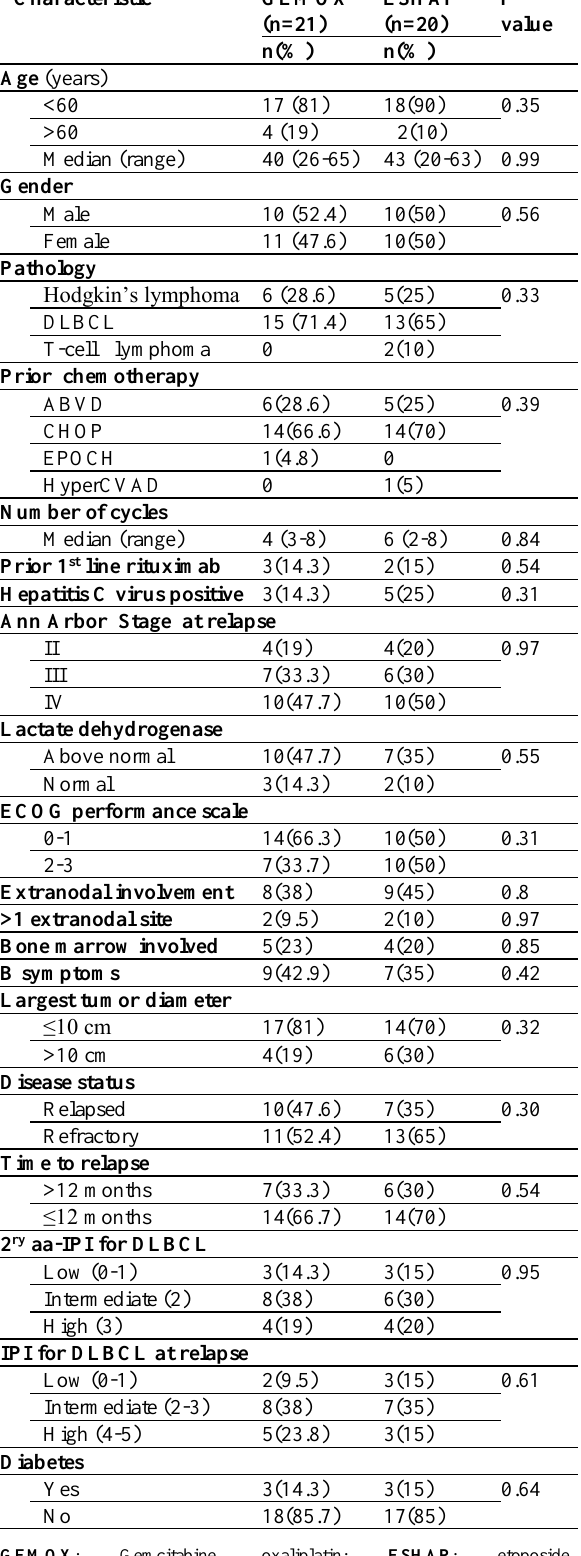
Table 1. Patients’ characteristics